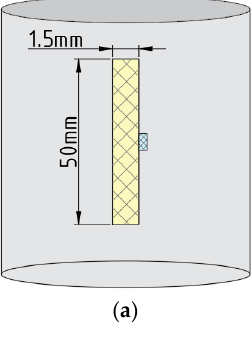
Figure 7. Geometric models of the experiment (side view): ( a ) surface component, without a copper layer; ( b ) embedded component, without a copper layer; ( c ) surface component, with a copper layer; ( d ) embedded component, with a copper layer.